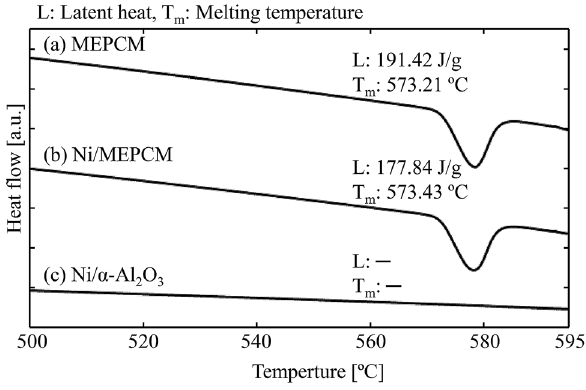
Figure 7. Heating DSC curves of the MEPCM, Ni/MEPCM, and Ni/ α-Al 2 O 3 .